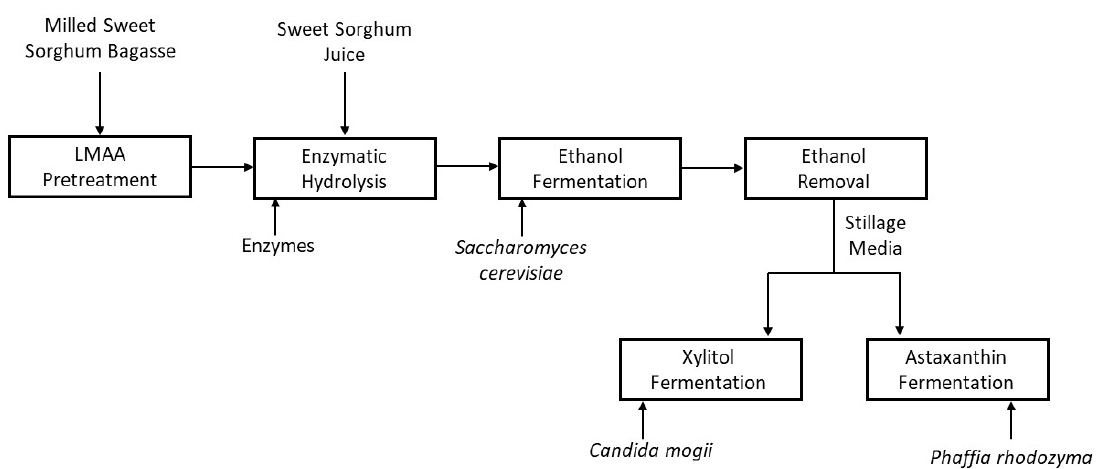
Figure 1. Simplified experimental progress from sweet sorghum bagasse (SSB) pretreatment to stillage media fermentation.